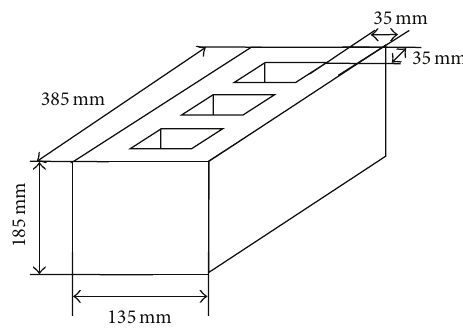
Figure 2: Dimensions of a hollow concrete stretcher block are 385 mm × 185mm × 135mm (length, height, and width, resp.). The outer structure is 35 mm